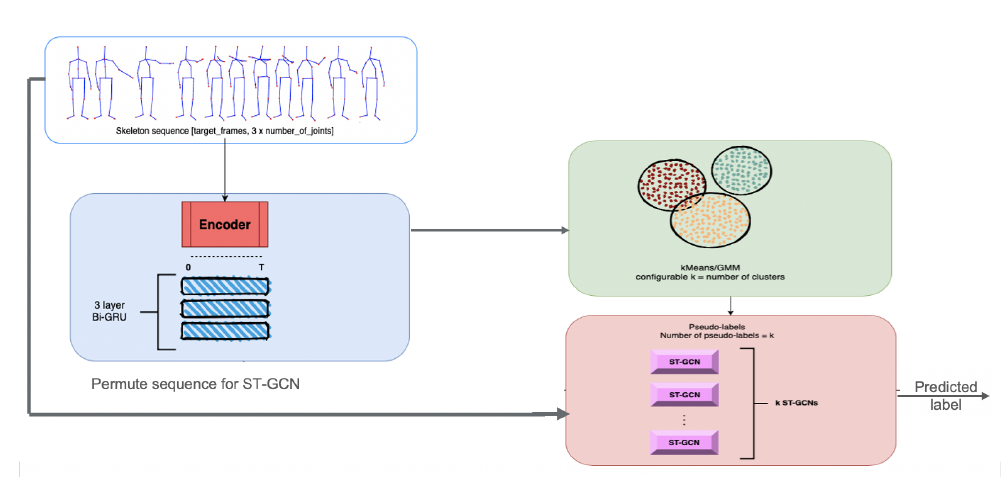
Figure 3. The architecture of the proposed